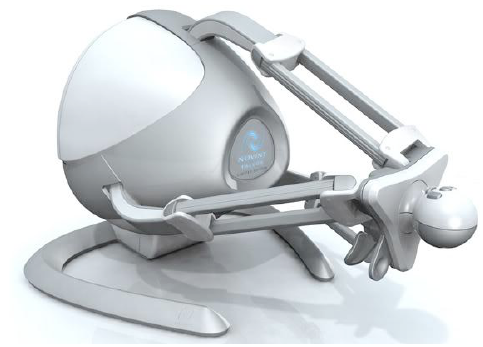
Figure 1: The Novint Falcon 3D Controller Figure 1. The Novint Falcon 3D